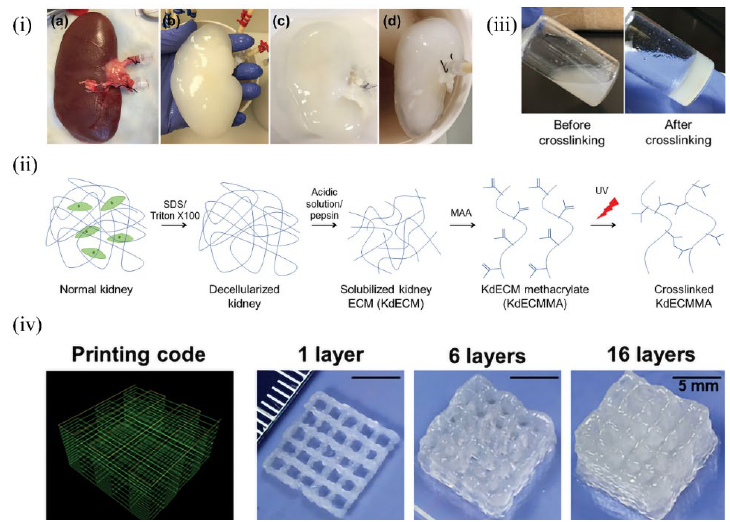
Figure 10. Preparation of KdECM and KdECMMA-based bioink formulations: changes in gene expression in the 3D-printed cell-laden construct: ( i ) gross images of the decellularization process: (a) normal kidney, (b) SDS treatment for 36 h, (c) Triton X-100 treatment for 24 h, and (d) washing in saline for 72 h; ( ii ) schematic illustration of a photo-cross-linkable kidney-specific ECM hydrogel; ( iii ) photography of KdECMMA before and after UV cross-linking; ( iv ) printing code and